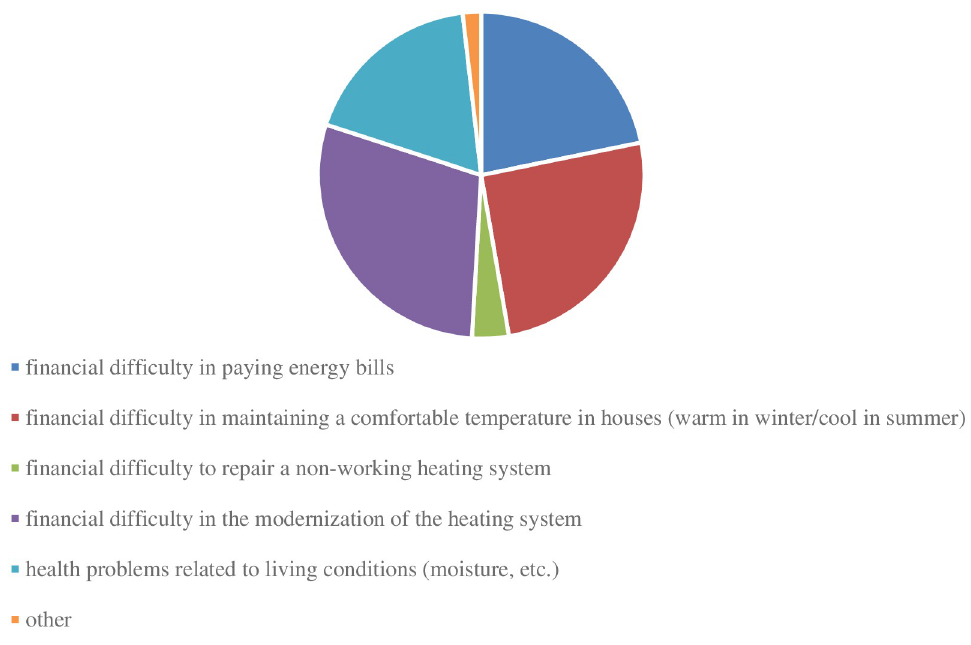
Fig 3. Main problems reported to agricultural advisors in the field of energy poverty in rural areas. Source: Own study based on questionnaire surveys (N = 16).